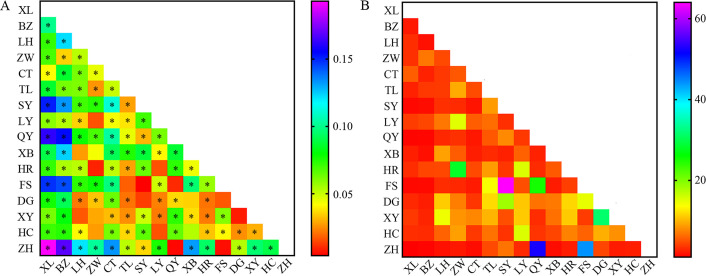
Heatmap of pairwise genetic differentiation (FST) values and gene flow (Nm) values between 16 populations of Chilo suppressalis in the typical bivoltine areas of northern China based on 12 microsatellite loci.*P < 0.05. The colours indicate FST or Nm values ranging from deep red (lower values) to purple (higher values). See S1 Table for population codes.